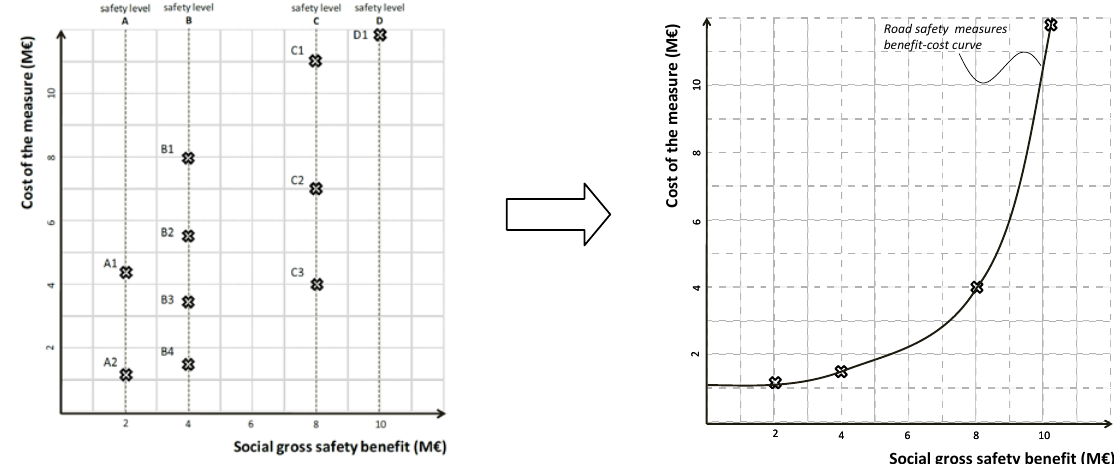
Figure 1. Theoretical relationship between gross social benefit and gross social cost for different measures to achieve better road safety